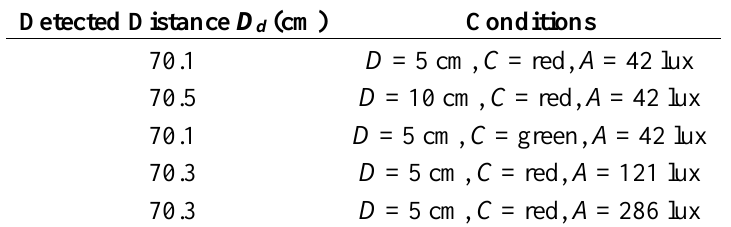
Table 3. Distance detection results at different diameters of the label D , colors of the label C , and ambient illuminations A when the real distance D r = 70